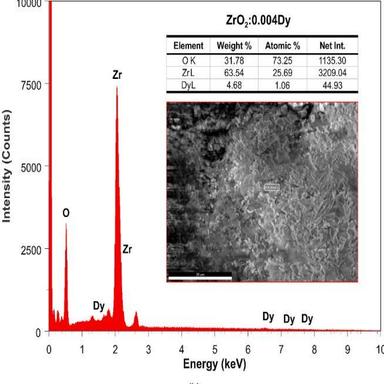
EDS spectra with elemental composition of (a) ZrO2 (b) ZrO2:Dy3+ (c) ZrO2:Dy3+,K+.